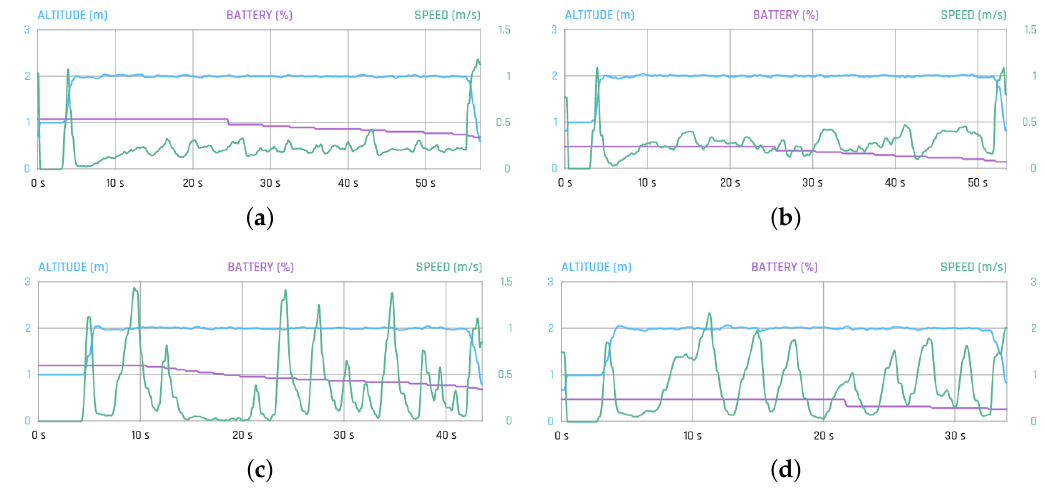
Figure 24. Results of three fixed obstacles. ( a ) Autonomous control; ( b ) bang-bang control ( c ) teleoperator with experience; ( d ) teleoperator without experience